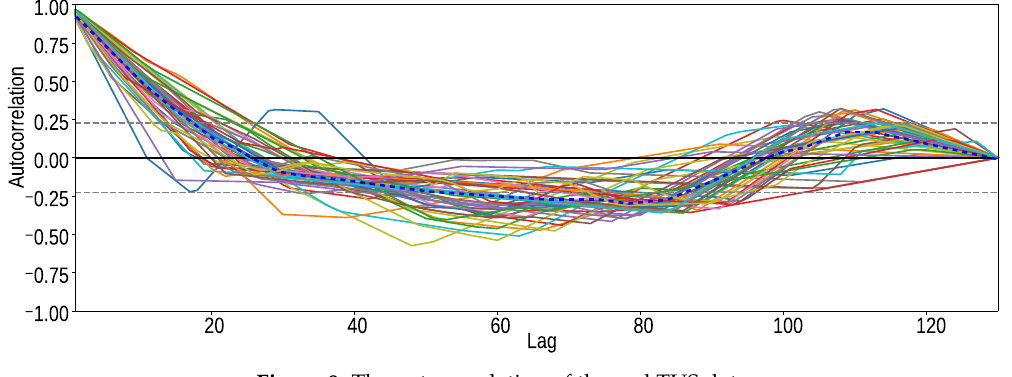
Figure 9. The autocorrelation of the real TUS data.